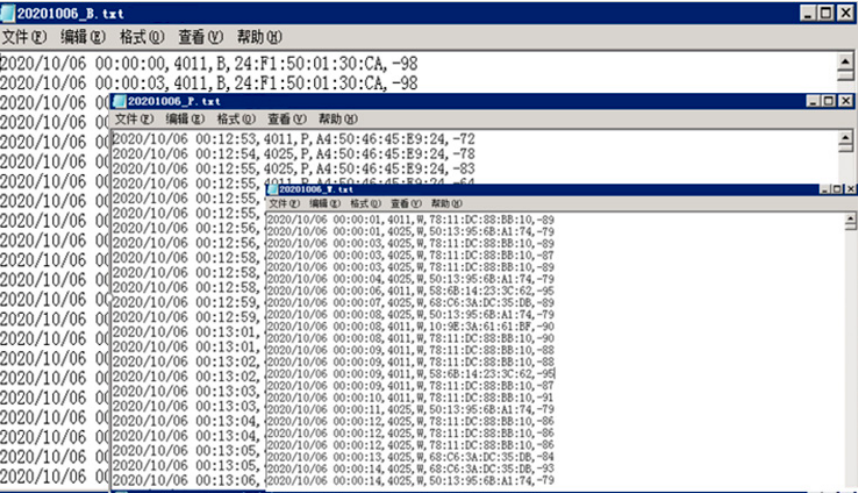
Figure 4. The text format of B, P and W for storing data.